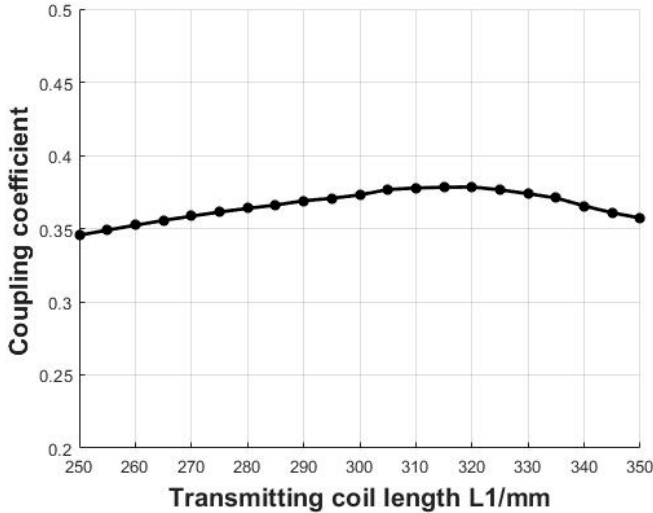
Figure 7. Simulation results of coupling coefficients at different L1.